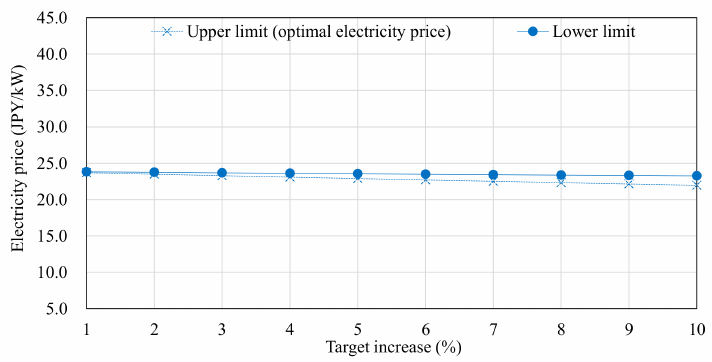
Figure 10. Results on the typical time slots in scenario 2 (at 4:00). In this scenario, the power suppliers could not request the DR cooperation in the target period.